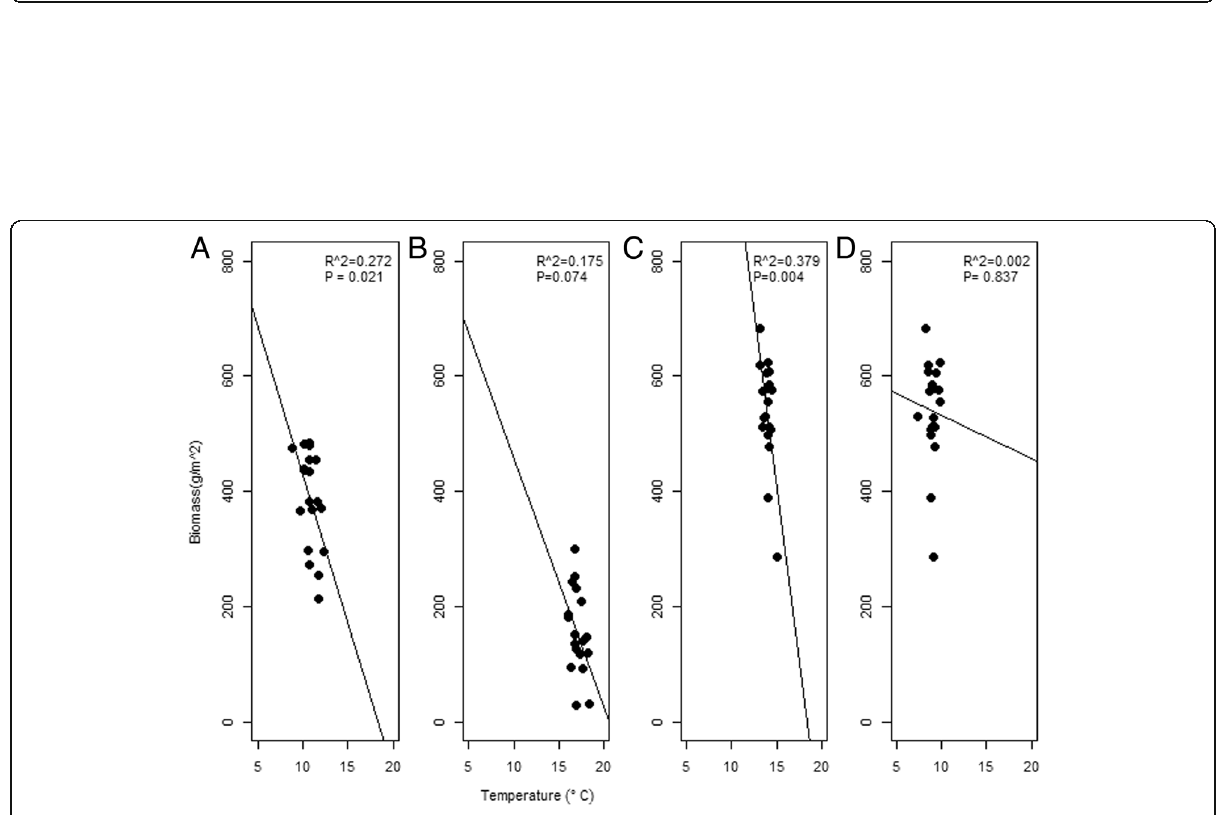
Fig. 2 Variation of aboveground biomass production in June, September, and annual across 19 years ( a ), pre-drought (1997 – 2002) ( b ), and post-drought (2003 – 2015) ( c )